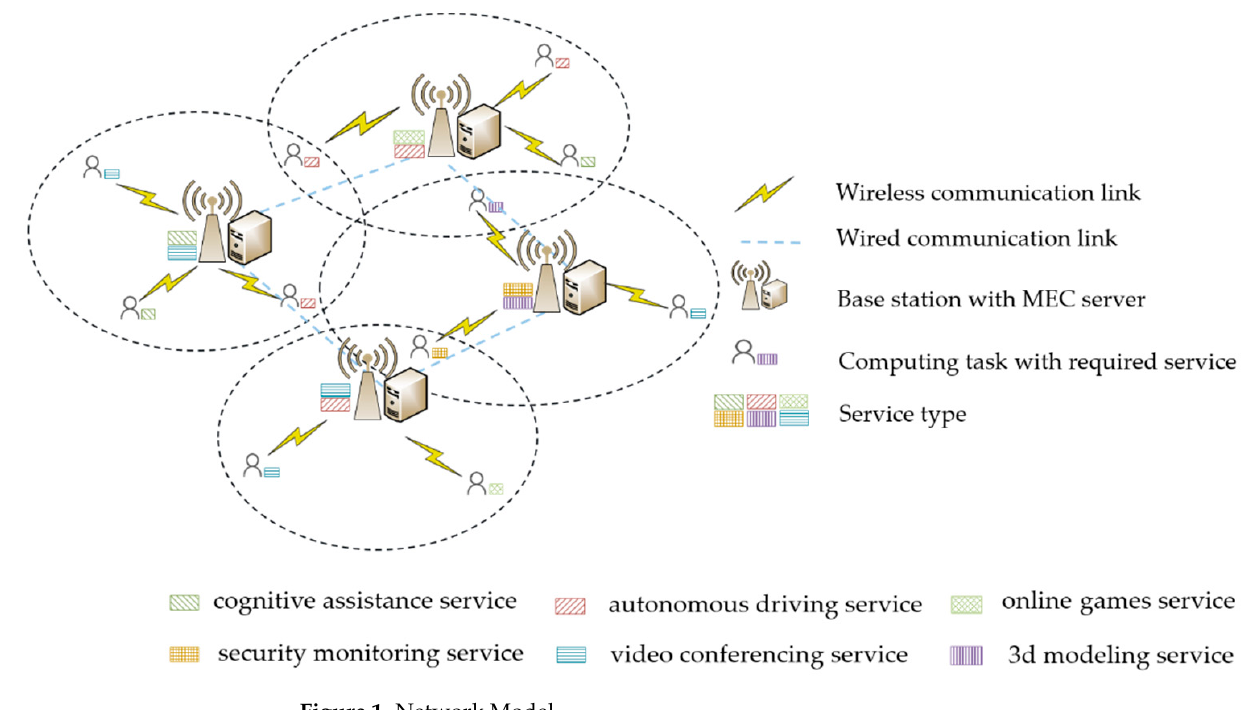
Figure 1. Network